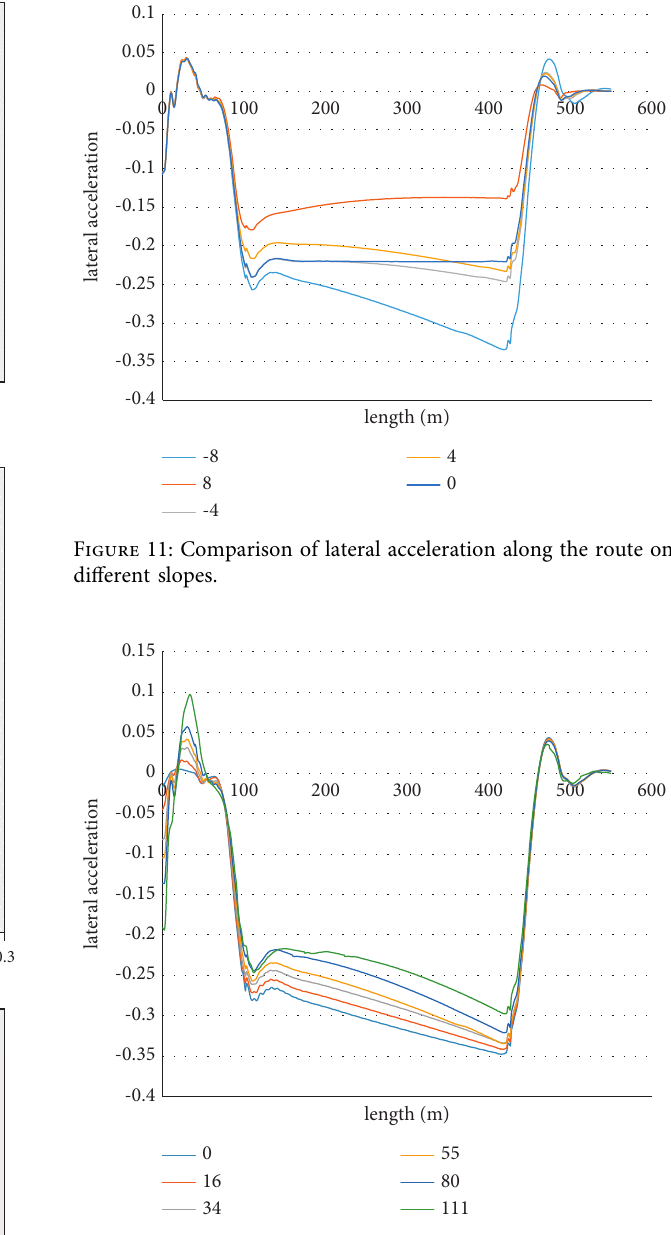
Figure 12: Comparison of lateral acceleration along the path at different wind speeds.